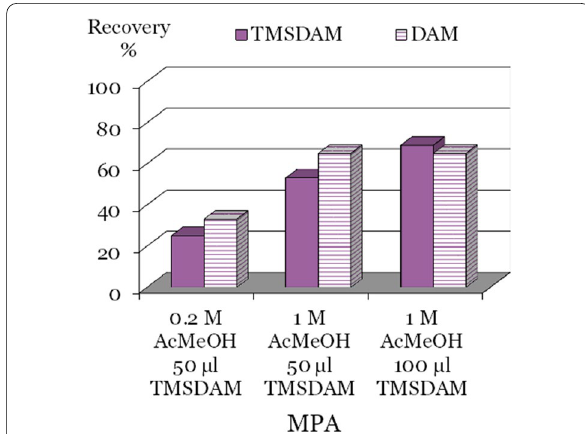
Fig. 3 Recovery (%) of MPA (10 µg/ml) in aqueous extracts of clay soil. The solution was cation‑exchanged and evaporated to dryness, and the residue was dissolved in 0.2 M or 1 M AcMeOH before TMSDAM methylation (0.05 ml or 0.1 ml of TMSDAM). The recovery of MPA derivatized by DAM is shown for comparison